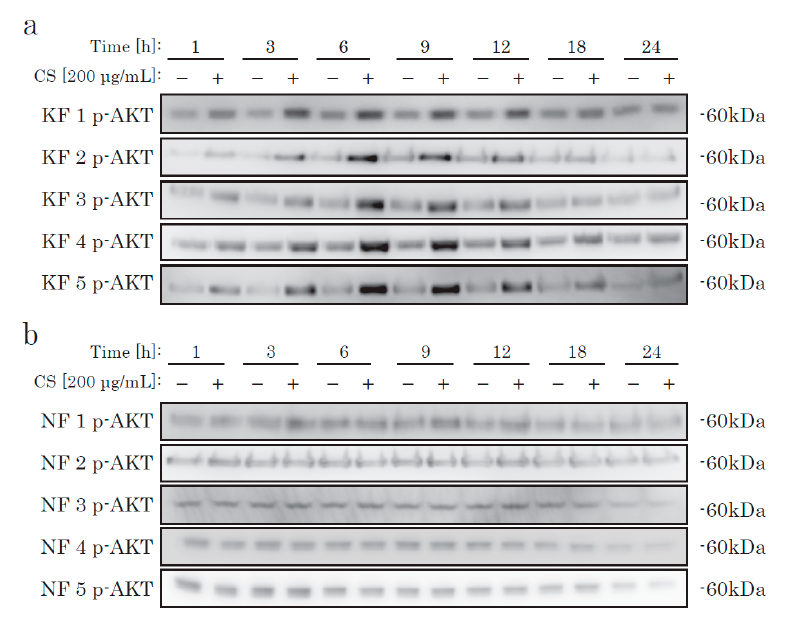
Figure 3. The time-dependent phosphorylation of AKT in KFs cultured with CS. KFs ( a ) and NFs ( b ) were incubated with CS and analyzed by Western blotting using an antibody specific to phosphorylated AKT.